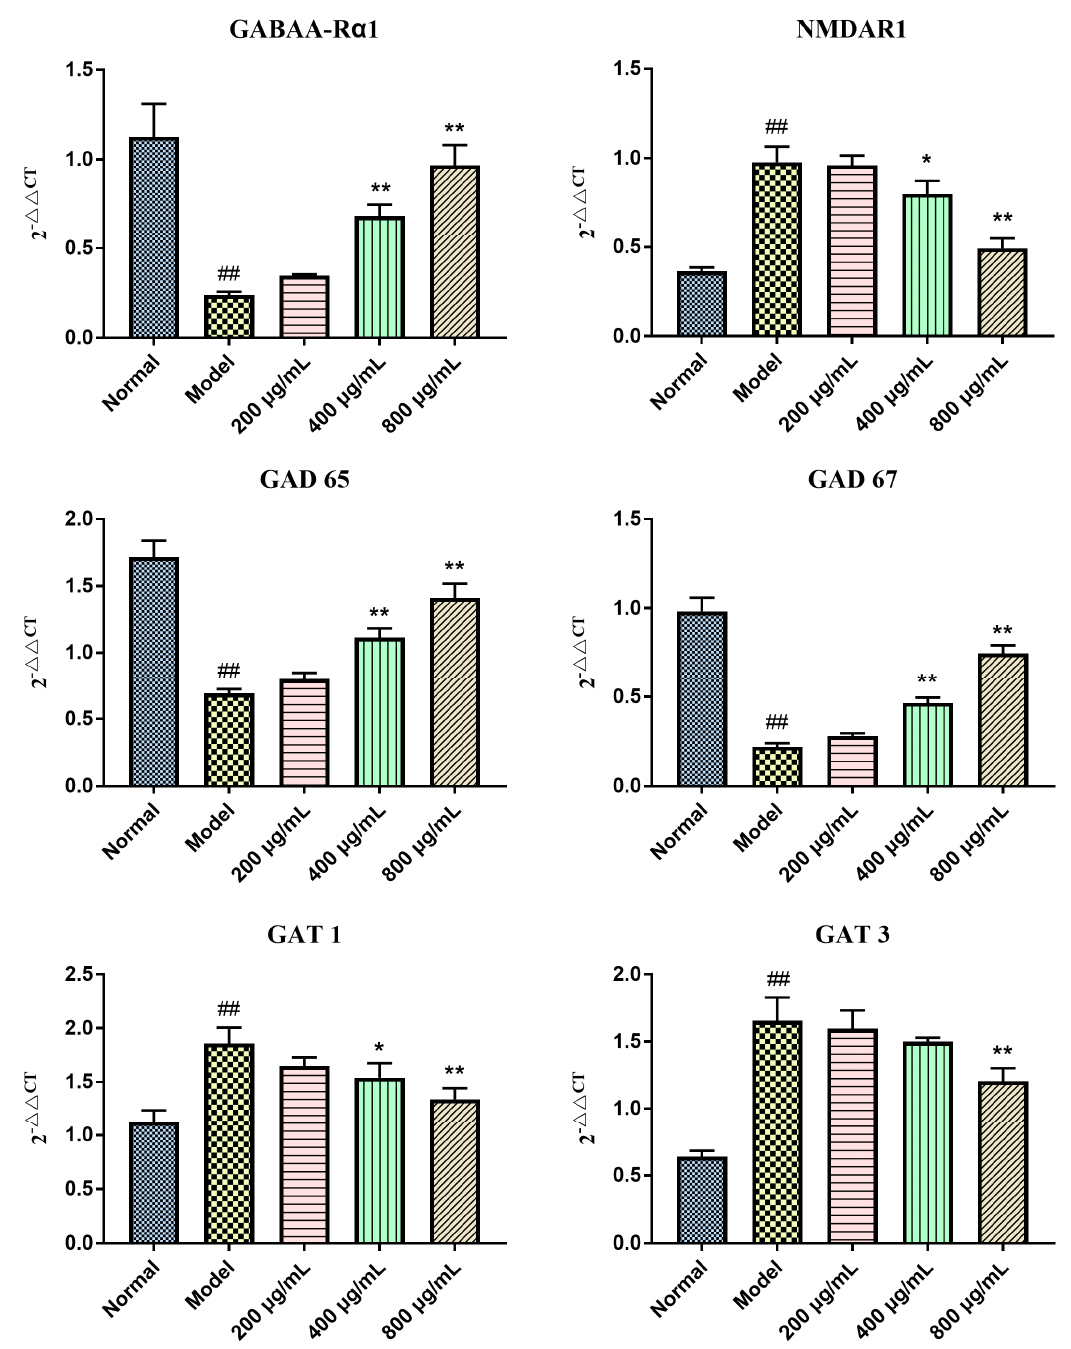
Figure 4. Effects of BBPs on mRNA expressions of GABAA-R α 1 , GAD 65, GAD 67, NMDAR1 , GAT 1 and GAT 3 in NGF-induced PC12 cells injured by Glu. PC12 cells (induced by 50 ng/mL NGF for 48 h) were treated with BBPs at concentrations of 200, 400 and 800 μ g/mL for 24 h, subsequently subjected to Glu at the concentration of 20 mmol/L for a further 24 h. GABAA-R α 1, NMDAR1, GAD65, GAT 1, GAT 3 and GAD67 mRNA were detected by real-time PCR and β -actin was detected as the control. Normal group: NGF-induced cells without BBPs and Glu; Model group: NGF-induced cells without BBPs, but with 20 mmol/L Glu; BBPs: protein extracts in Bombyx batryticatus. The values represent mean ± SD ( n = 3). ## P < 0.01, vs. normal group; * P < 0.05 and ** P < 0.01, vs. model group.